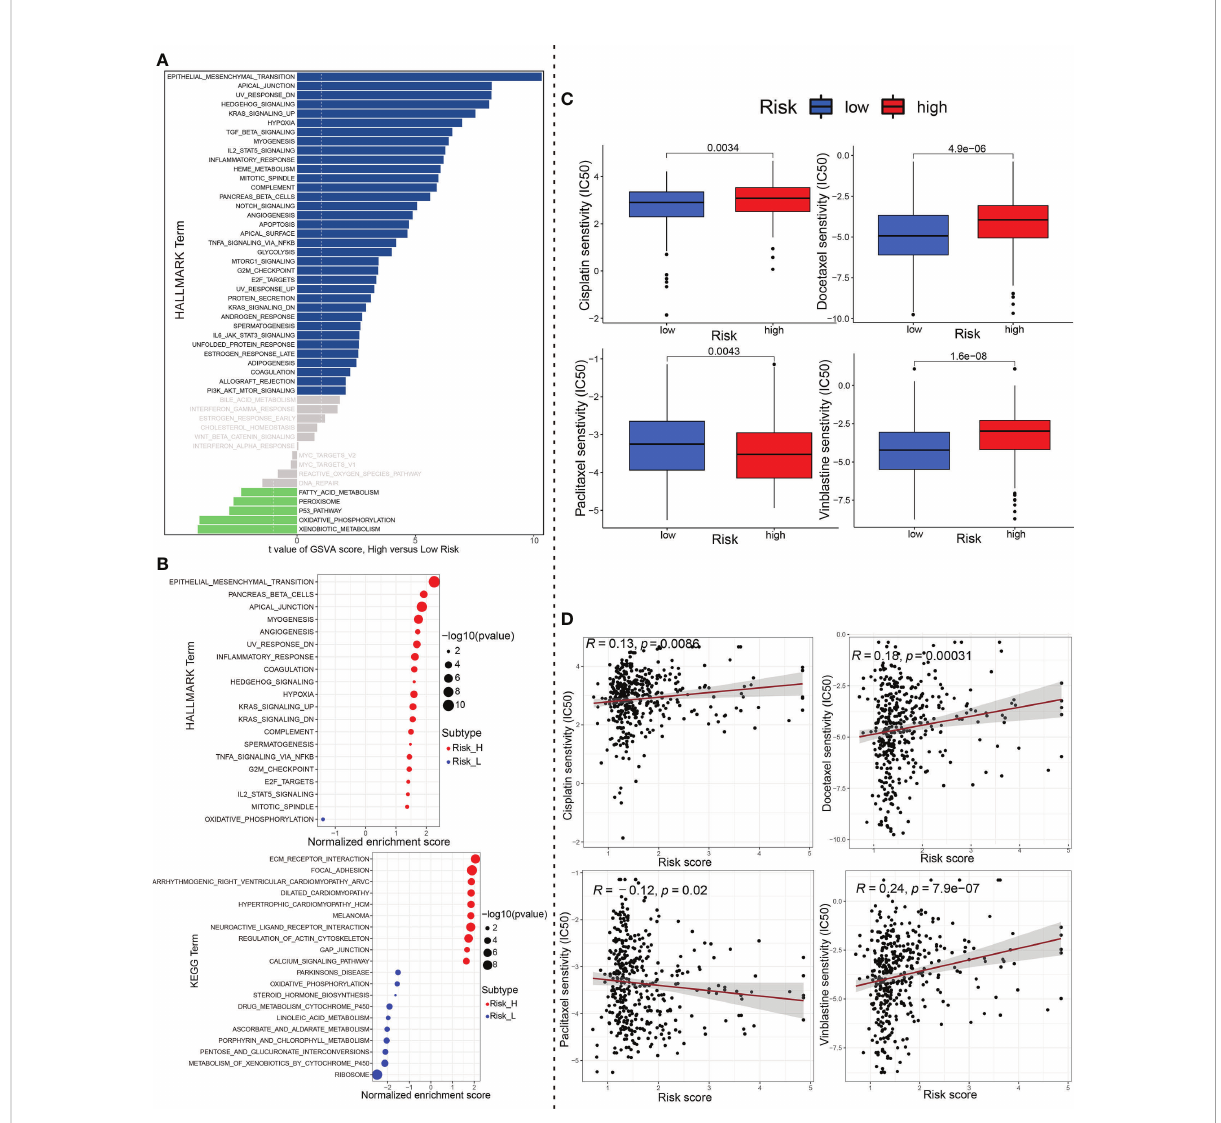
FIGURE 9 The underlying molecular mechanisms and chemotherapeutics. (A) Differences in pathway activities scored by GSVA of HALLMARK gene sets between high-risk and low-risk group. Navy blue, signi fi cantly upregulated enrichment; green, signi fi cantly downregulated enrichment; grey, no enrichment. (B) Most signi fi cant enriched 20 GSEA pathways in high- vs. low-risk group were displayed separately based on KEGG and HALLMARK gene sets. Red, signi fi cant positive enrichment; green, signi fi cant negative enrichment. (C) Wilcox group analysis and (D) spearman correlation analysis indicated that the ceRNA-associated gene model is robust to drug sensitivity of Cisplatin, Docetaxel, Paclitaxel and Vinblastine. GSVA, Geneset variation analysis; GSEA, gene set enrichment analysis; ceRNA, competing endogenous